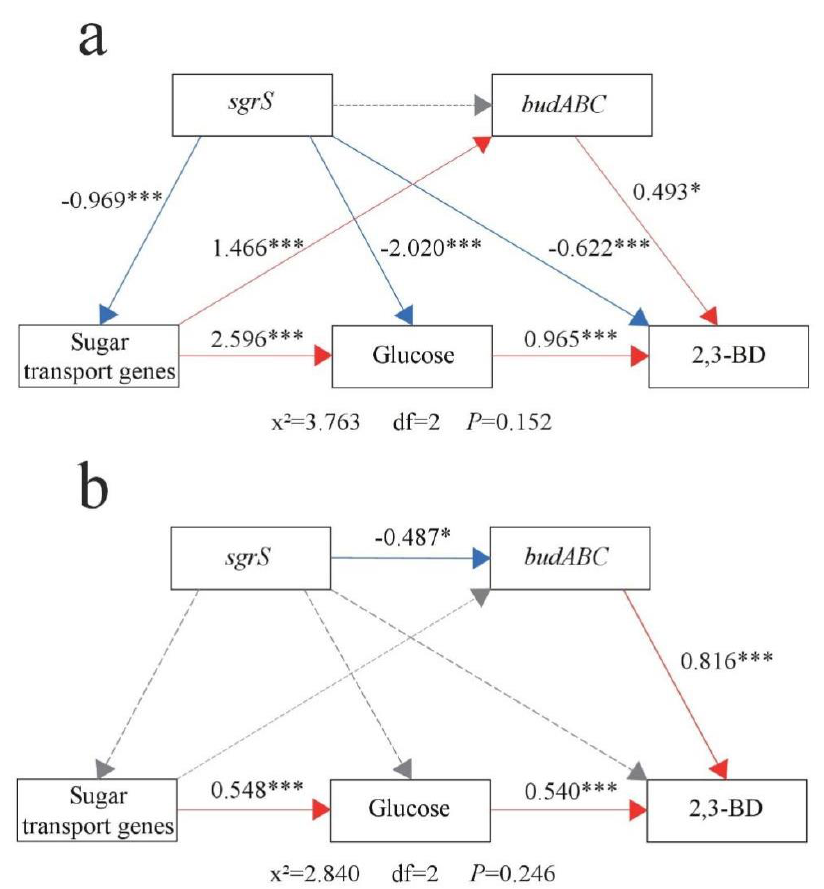
Figure 8. Structural equation models (SEM) showing the direct and indirect effects of the sgrS gene, sugar transport regulatory genes, budABC genes, glucose metabolism, and 2,3-BD production, during fermenting. ( a ) shows the relationship of indexes in K. pneumoniae HD79 series strains; ( b ) shows the relationship of indexes in K. pneumoniae HD79-02 series strains. The line outlined in gray indicates no significance ( p > 0.05). The solid red line shows a positive association, and the solid blue line shows a negative association (* p < 0.05, *** p < 0.001). Numbers on arrows were standardized pathways coefficients indicating the degree of influence for relationships.